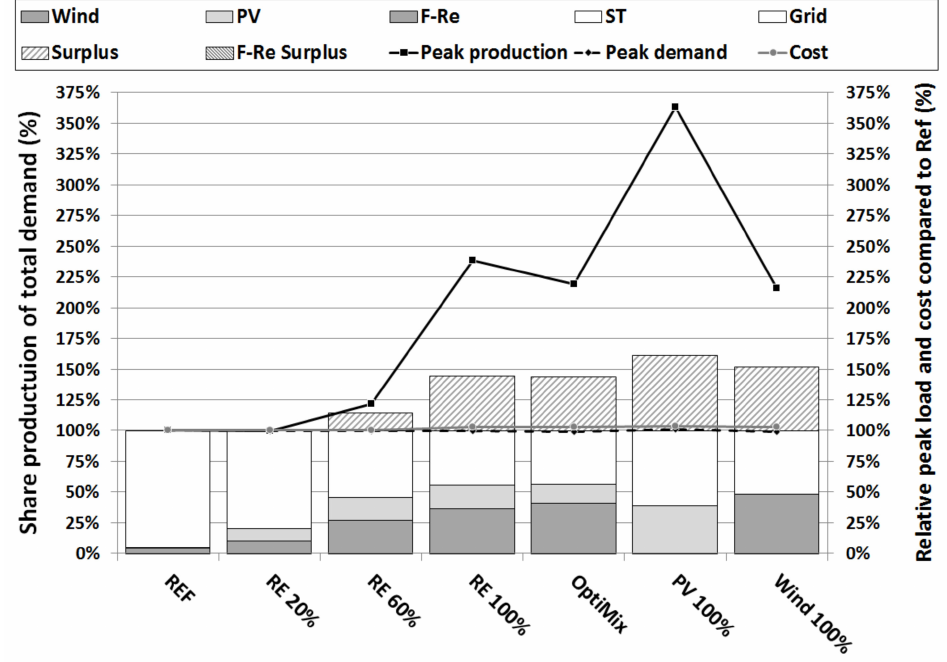
Figure A6. Main yearly results from the renewable integration scenarios.